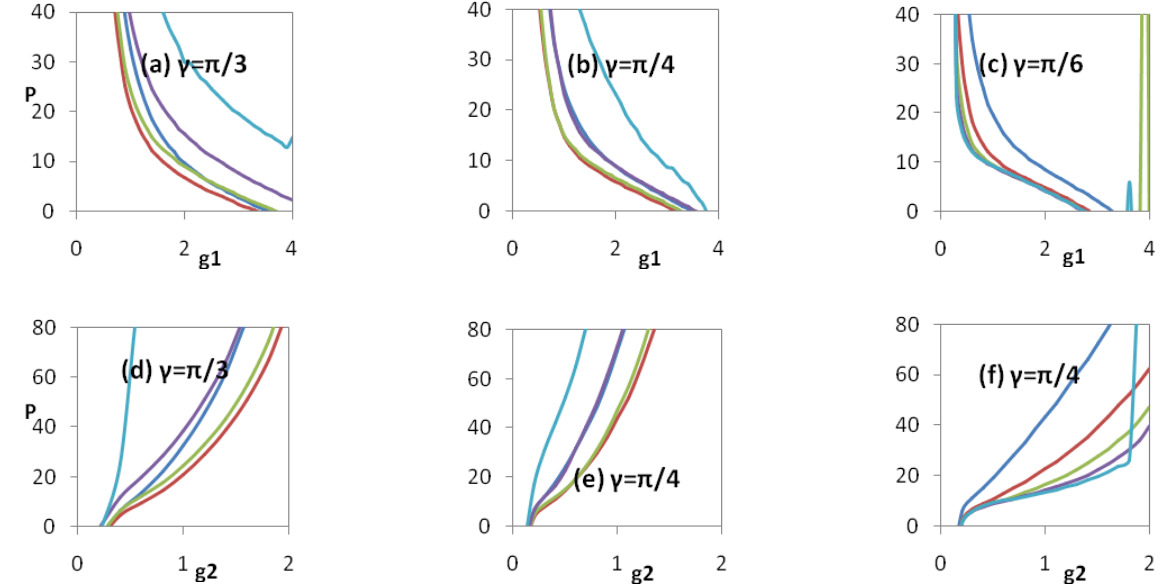
Figure 4: Buckling of confined growing tube–enforced circular outer boundary condition. One layer model with growth. µ =5kPa, k 1 =1, k 2 =0.2. A/B=0.5. (a-c) Critical pressure plotted against radial growth rate g 1 . (d-f) Critical pressure plotted against circumferential growth rate g 2 .